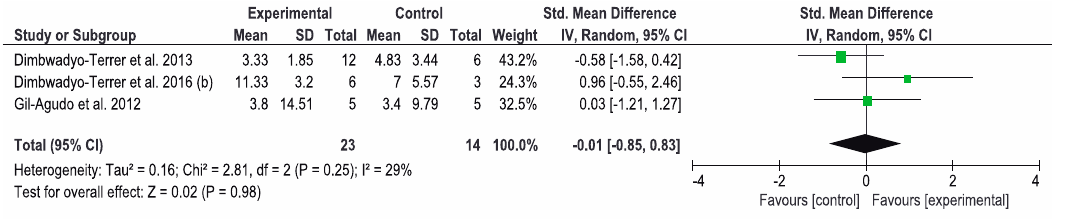
Figure 5. Forest plot for functional performance measured by SCIM scale. A green block indicates the weight assigned to the study and the horizontal line depicts the confidence interval. A black rhombus shows the overall result.